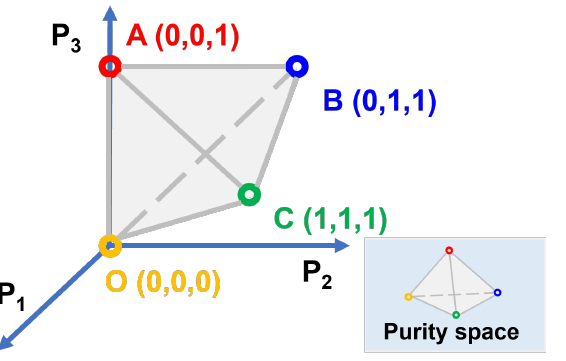
Figure 1. Purity space comprised of the three IPPs metrics (i.e., P 1 , P 2 , P 3 ), which are the coordinates in the purity space.